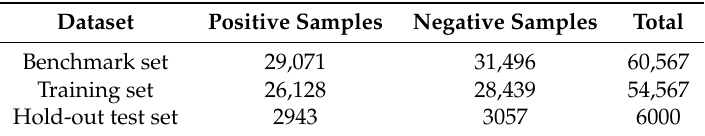
Table 1. Benchmark